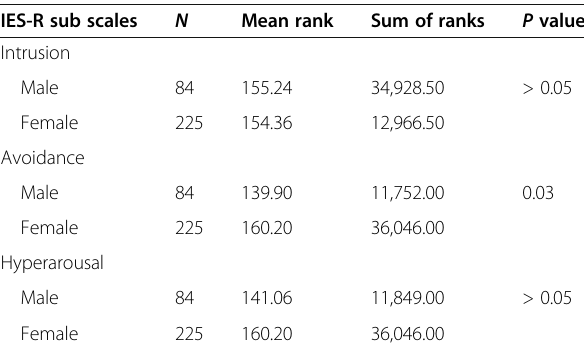
Table 2 Participant ’ s IES-R score according to the gender